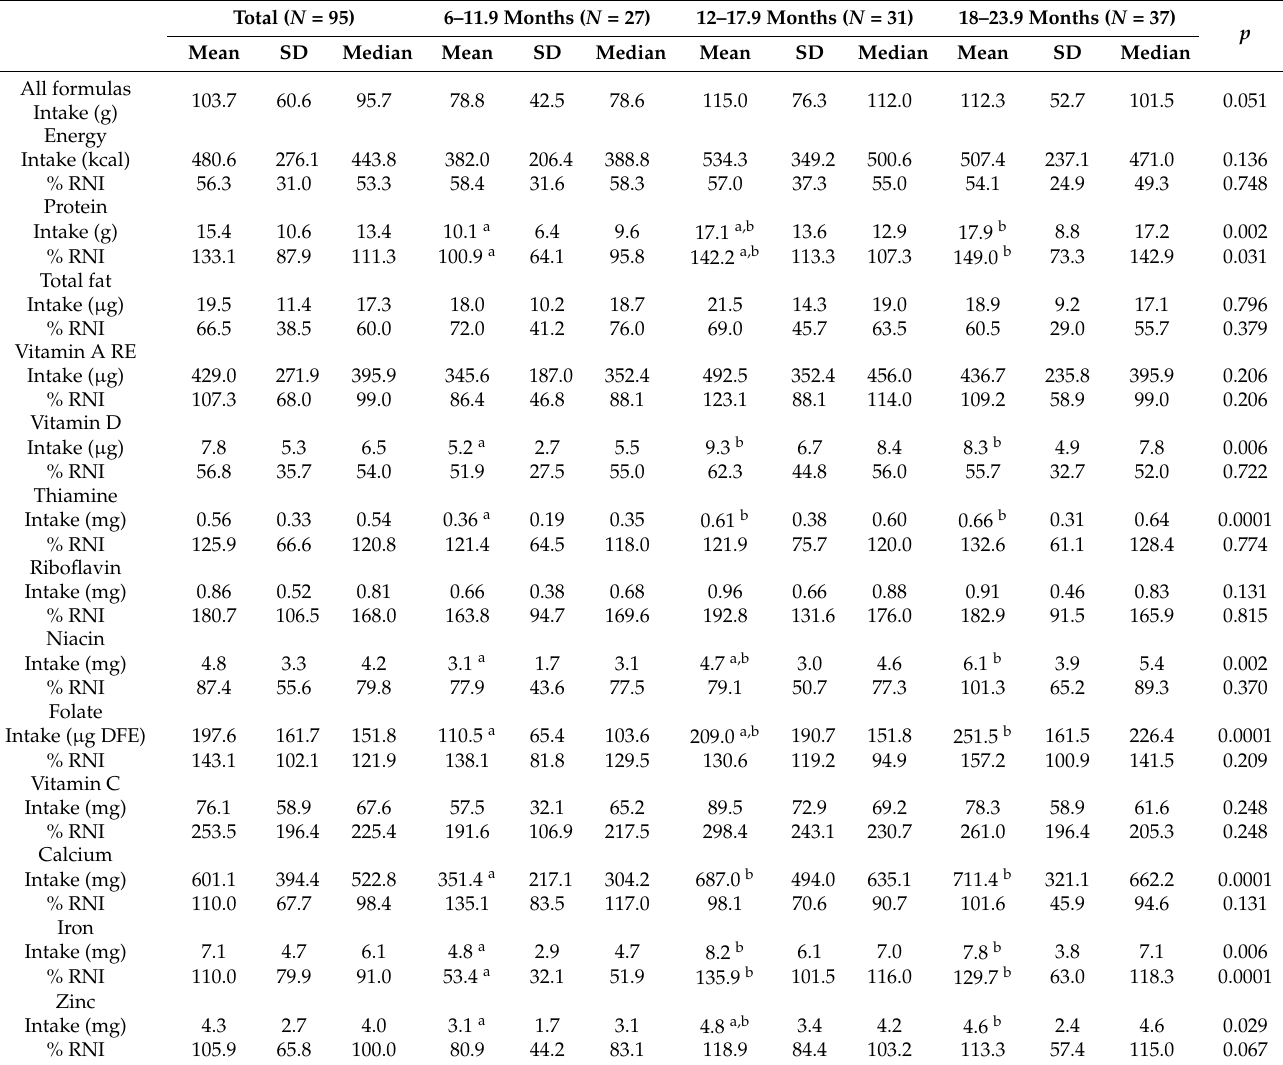
Table 6. Energy and nutrient intake from milk-based formulas per day (mean ± SD and median) according to age group ( N =